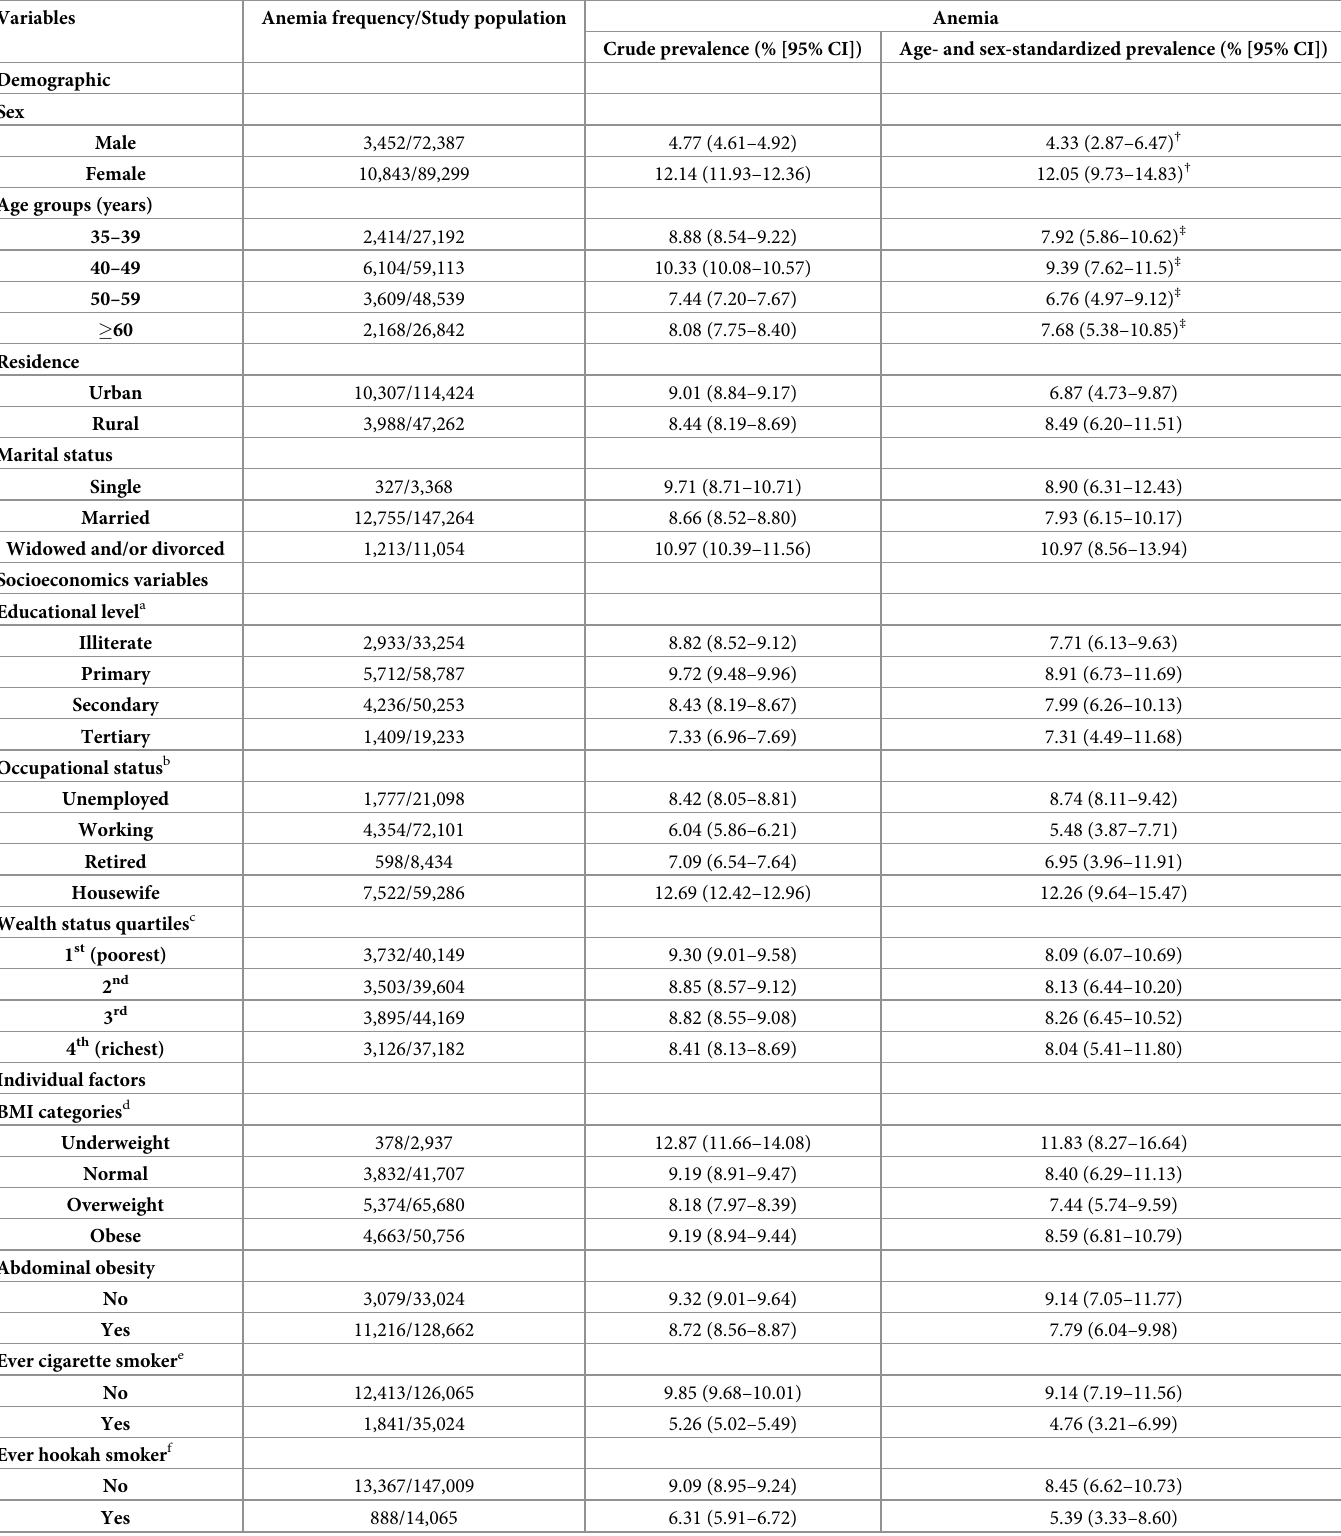
Table 1. Prevalence of anemia by characteristics of